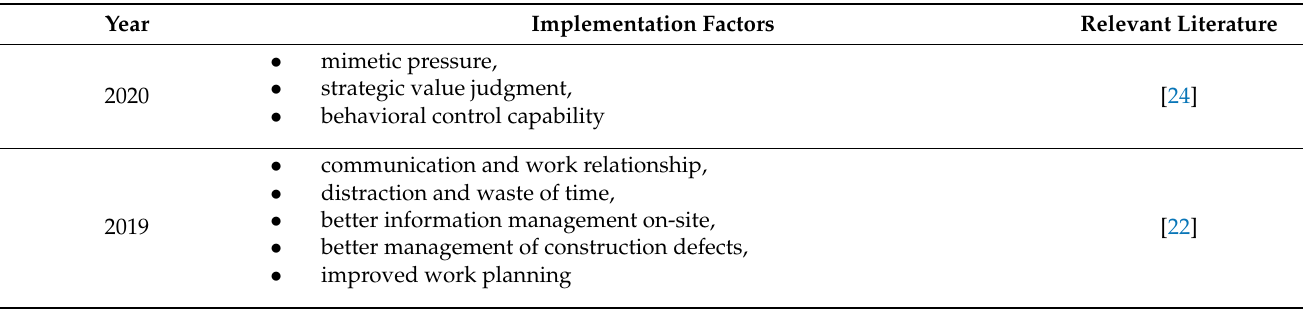
Table 1. Literature review of information and communication technology (ICT) implementation factors in the construction industry